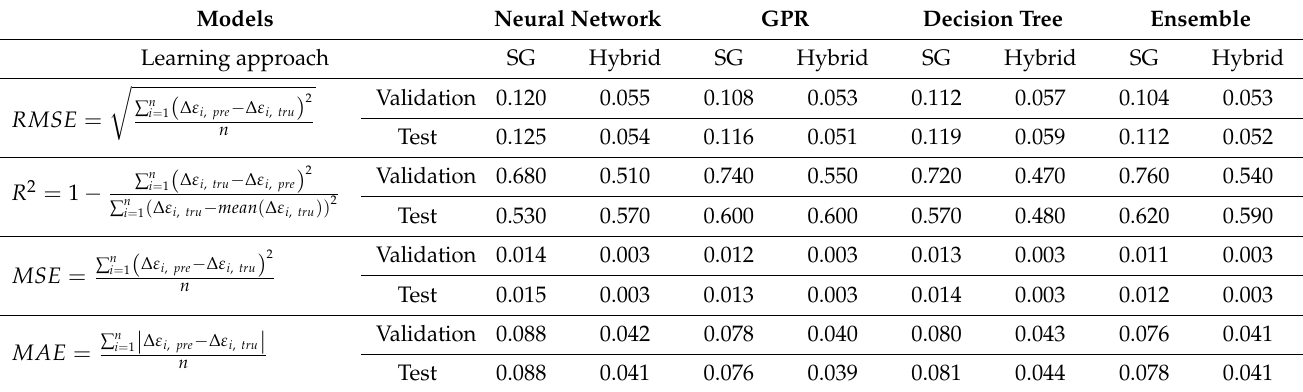
Table 6. Performance measures of each model considering both approaches in training and test phases.